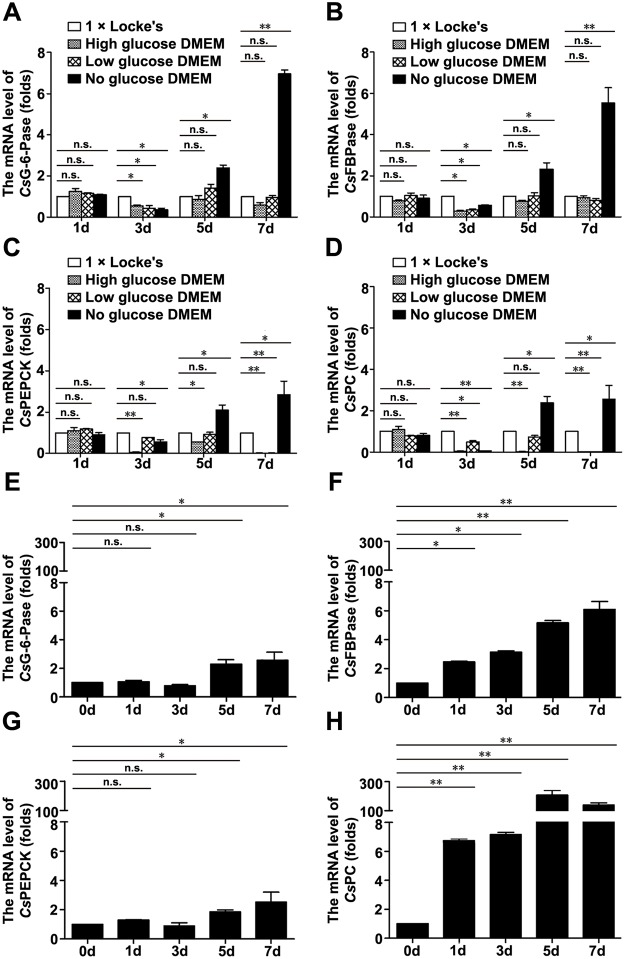
The mRNA levels of CsG-6-Pase, CsFBPase, CsPEPCK, and CsPC in 1 × Locke’s and different DMEM.The mRNA levels of CsG-6-Pase (A), CsFBPase (B), CsPEPCK (C), and CsPC (D). Time course of CsG-6-Pase (E), CsFBPase (F), CsPEPCK (G), and CsPC (H) mRNA levels in no glucose DMEM. ANOVA was used to analyze the comparisons. *P < 0.05 and **P < 0.01 versus 1 × Locke’s (A-D) or 0 d (E-H); n.s., not significant.